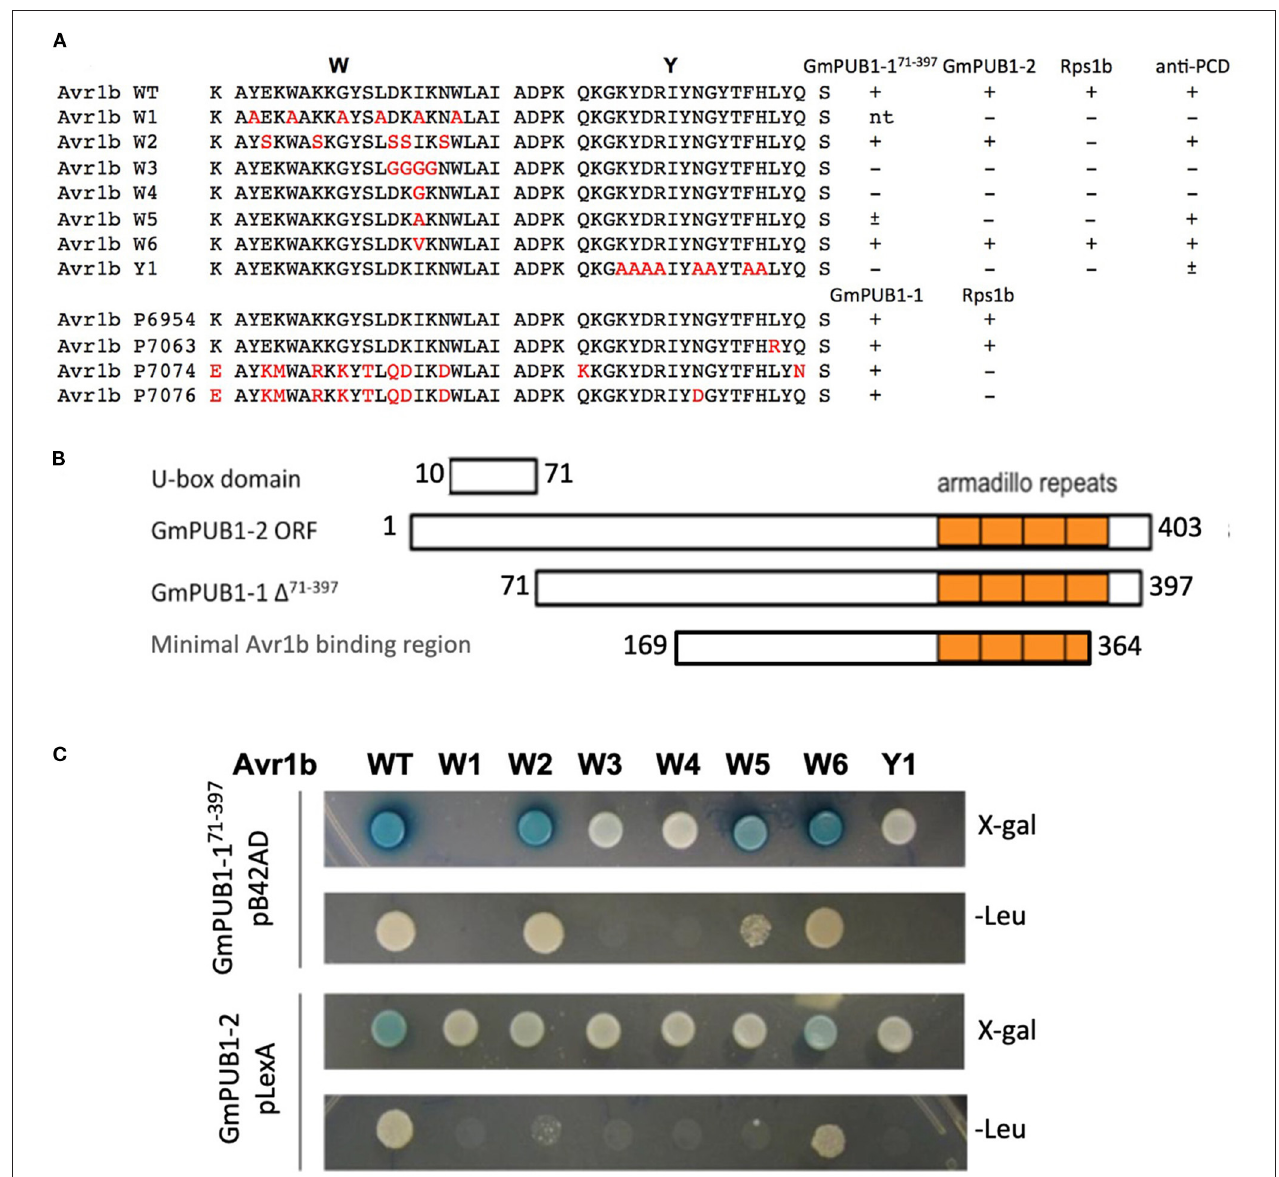
FIGURE 2 | Interactions of GmPUB1s with Avr1b and mutant Avr1b proteins. (A) Sequences of W and Y motifs of Avr1b, Avr1b mutants, Avr1b variants and their interaction with GmPUB1s and PCD responses in an Rps1 -b containing line. Sequence differences are in red. + , interaction; -, no interaction; ± , partially active; n.t., not tested. Anti-PCD activity was cited from Dou et al. (2008), indicating the ability of Avr1b to suppress pro-apoptopic protein BAX-induced programmed cell death (PCD) in soybean leaves containing Rps1- b. (B) Schematic representation of protein fragment of GmPUB1s used in yeast two-hybrid assay, and the minimal region required for Avr1b binding, based on the fragment of GmPUB1-1 recovered in the original two-hybrid screen ( Table 1 ). (C) Yeast two-hybrid assays for in vivo interactions of GmPUB1 with Avr1b and mutant Avr1b proteins. Yeast strain EGY48/pSH18-34 containing combinations of truncated GmPUB1-1 in the prey vector pB42AD and C-terminal mutated forms of Avr1b in the bait vector pLexA, or full length GmPUB1-2 in the bait vector pLexA and Avr1b mutants in the prey vector pB42AD were grown on SD/Gal/Raf/X-gal/BU/-His/-Trp/-Ura plate and SD/Gal/Raf/-His/-Trp/- Ura/-Leu plate for 2 days to allow detection of LacZ and Leu2 gene expression respectively. Blue color in X-gal containing plate and colony growth on minimum medium lacking leucine suggest the presence of protein-protein